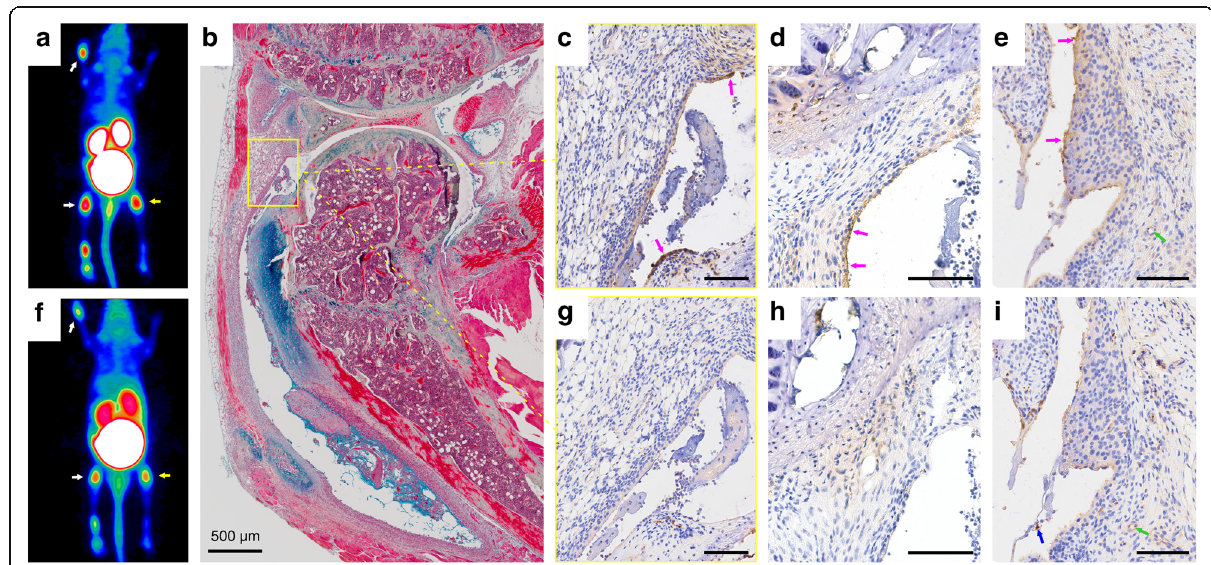
Fig. 4 Integrin expression in arthritic joints. a 68 Ga-Aquibeprin ( α 5 β 1-integrin) μ PET for a DBA mouse from week 4. b MOVAT pentachrome staining of the right knee of the same animal used for μ PET imaging ( a , f ). c – e α 5-integrin immunohistochemistry (IHC). f 68 Ga-Avebetrin ( α v β 3- integrin) μ PET for the same animal shown in a . g – i β 3-integrin IHC. α 5 and β 3 IHC, respectively, are shown for consecutive slices of the right knee ( c , g ; area shown corresponds to the frame in b ), left front paw ( d , h ), and left knee ( e , i ) of the same mouse used for PET (joints subjected to IHC are marked with arrows in a and f ). In many areas, the synovial membrane shows multifocal α 5 expression (indicated by pink arrows in c , d , and e ) but virtually no presence of β 3. Vascular endothelia (indicated by green arrows) show only a slight expression of α 5 ( e ) but a moderate level of β 3 ( i ). Furthermore, β 3 is expressed by macrophages ( i , blue arrow). In the respective arthritic joints, overall stronger α 5 expression gives rise to a more intense signal for 68 Ga-Aquibeprin ( a ) as compared to 68 Ga-Avebetrin ( f ). Unless otherwise noted, all scale bars indicate 100 μ m. Color coding of μ PET images ( a , f ) is similar to Fig. 2